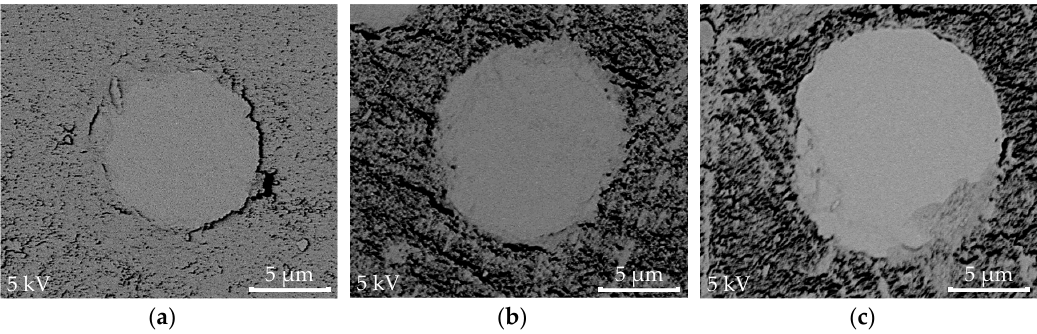
Figure 8. SEM micrographs of the interface and points for elemental analysis using EDS: ( a ) POM-GF-PT1.7; ( b ) POM-GF-PT9.5; ( c )